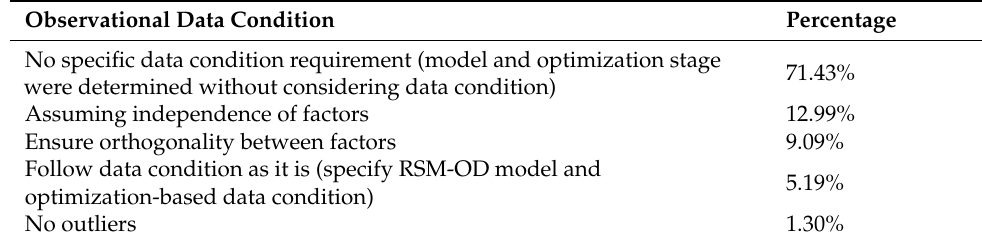
Table 5. Required data condition for RSM-OD.